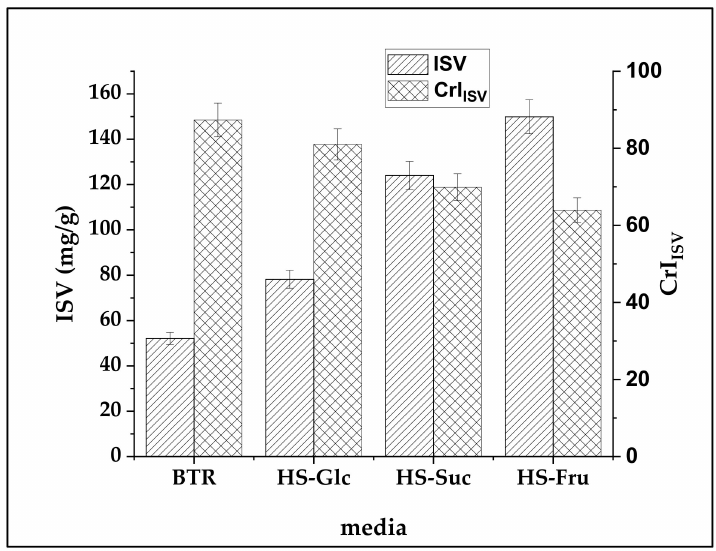
Figure 11. Iodine sorption value (ISV) of BNC and crystallinity index (CrI ISV ) calculated from